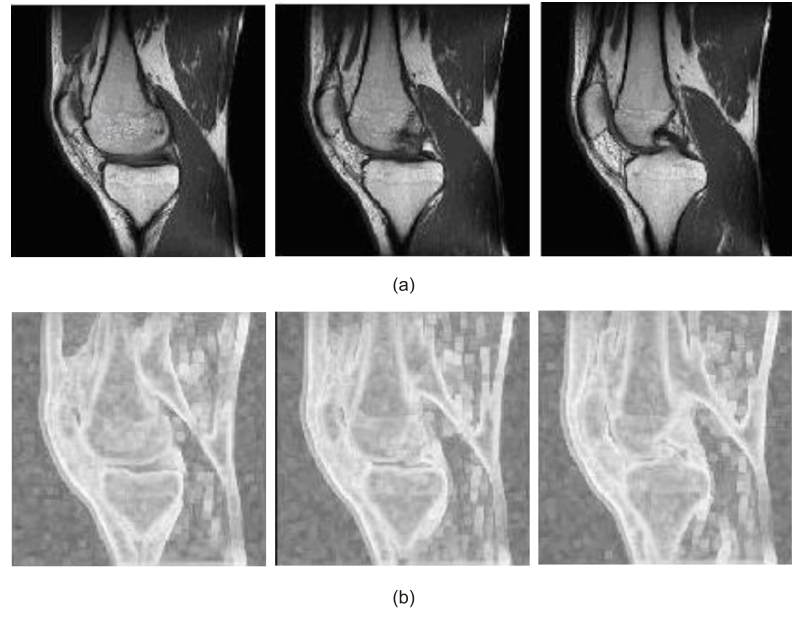
Figure 2. Clinical T1-weighted MRI studies of the knee joint (selected scans on the sagittal plane): ( a ) original signal and ( b ) entropy measure of